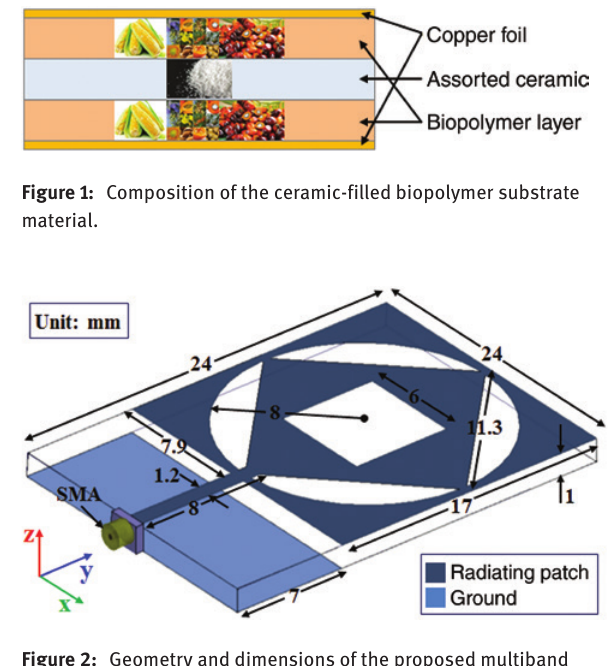
Figure 2: Geometry and dimensions of the proposed multiband planar antenna.